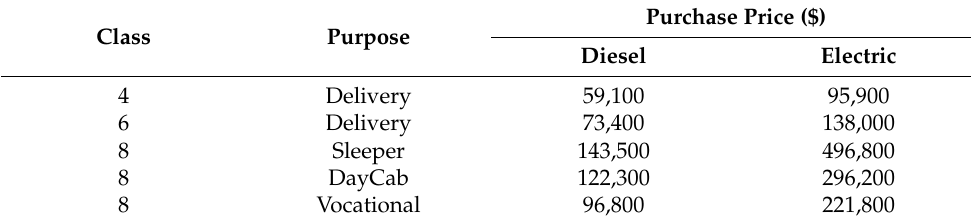
Table 4. Estimated purchase price of conventional and electric